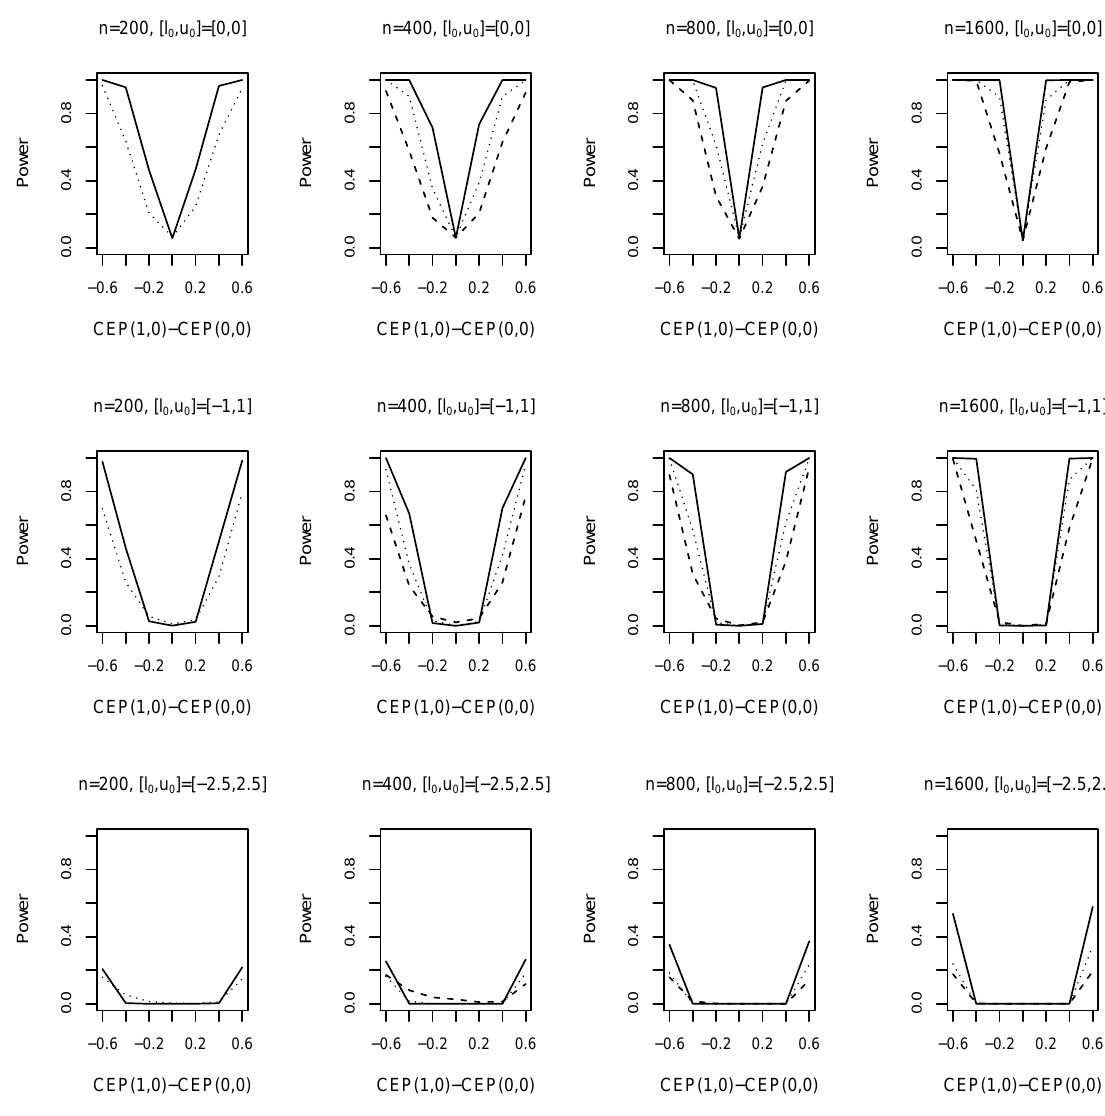
Figure 1: Power to reject H 0 : µ = CEP (1, 0) = CEP (0, 0) for the simulation study under Scenario NEE-CB . Solid black lines denote full cohort and dashed (dotted) lines denote case-cohort with 10% (25%) random